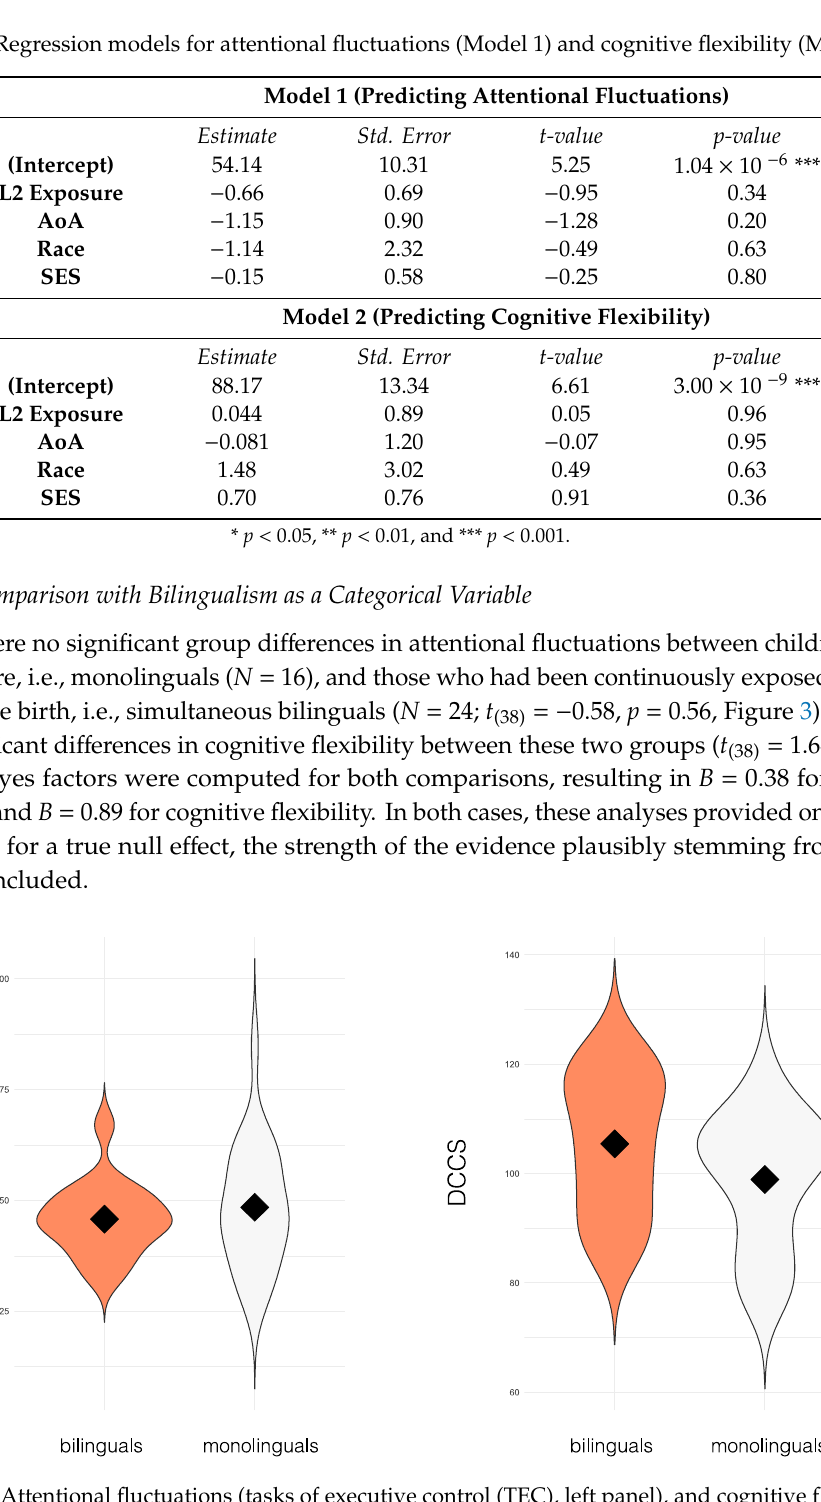
Figure 3. Attentional fluctuations (tasks of executive control (TEC), left panel), and cognitive flexibility (dimension change card sort task (DCCS), right panel) for bilingual ( N = 24) and monolingual ( N = 16) participants. Black diamonds represent group means, and the violin plot outlines illustrate the density of the data, i.e., the width of the shaded area represents the proportion of the data located there.